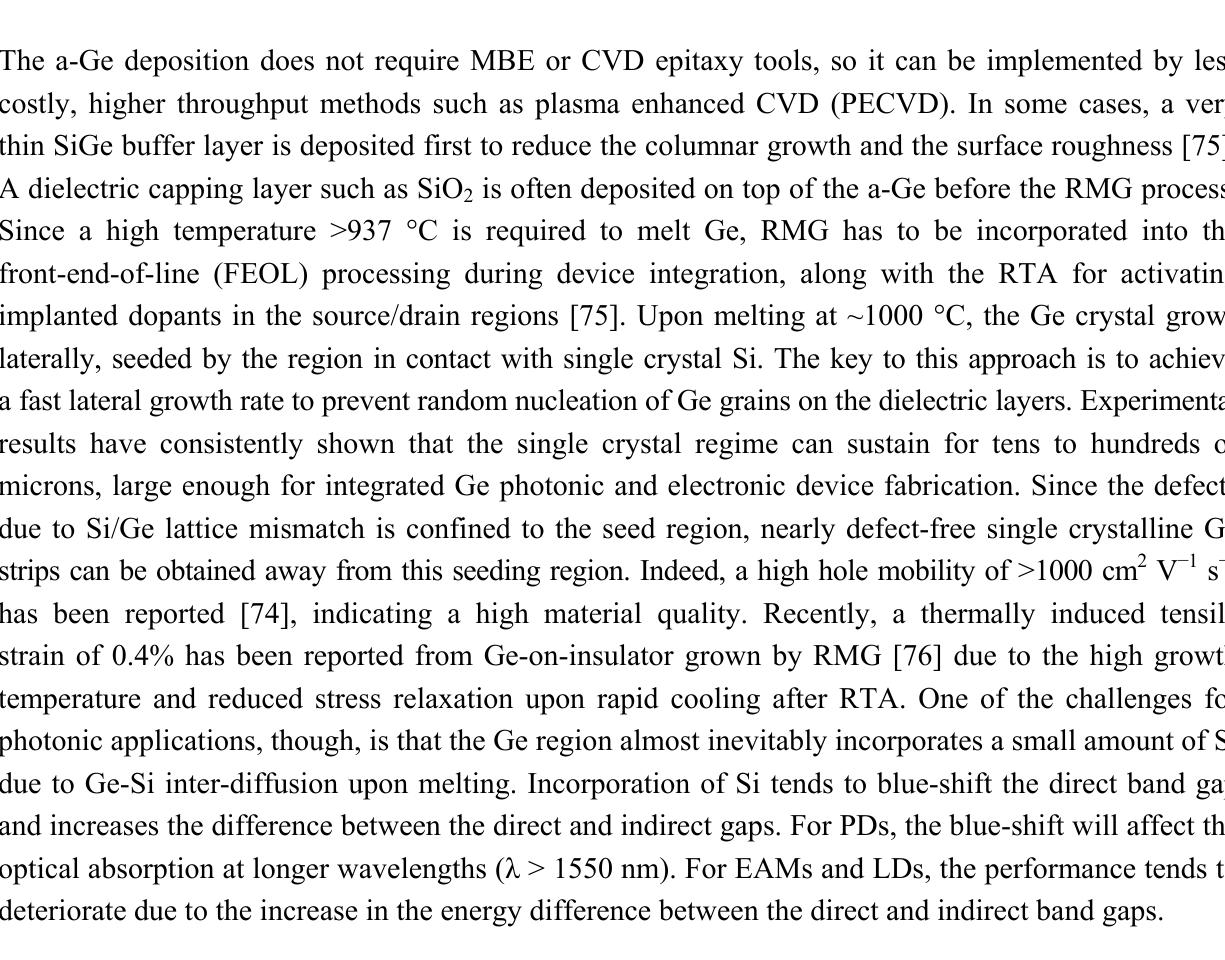
Figure 5. Schematics of a typical structure for Ge RMG/LPE growth. A cross-sectional view is shown